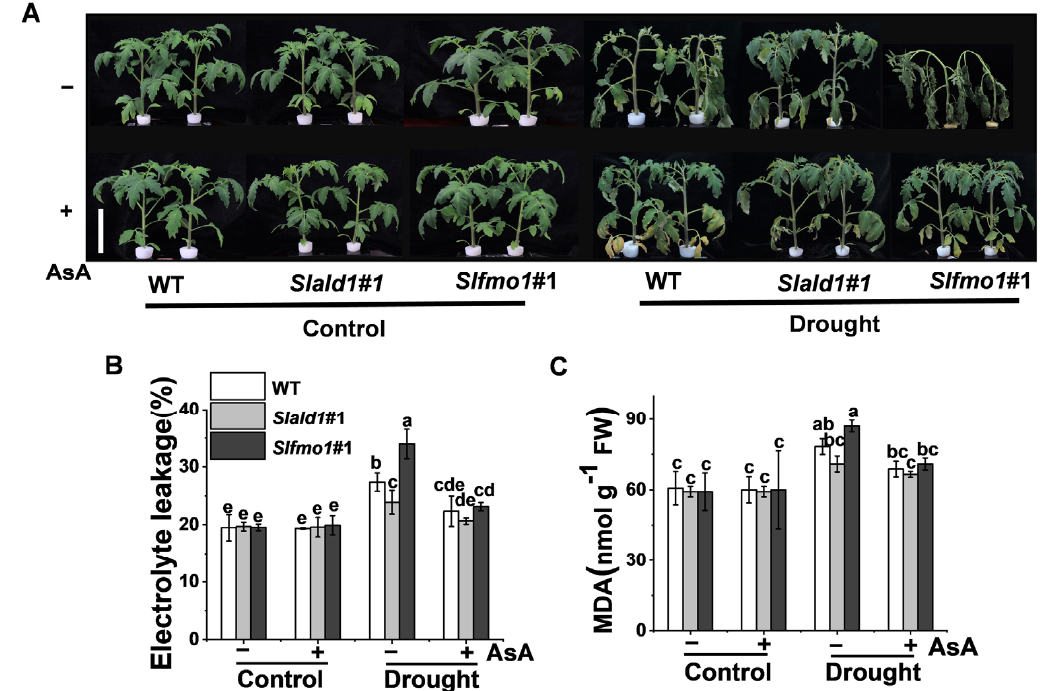
Figure 7. Drought-induced sensitivity in Slfmo1 mutants was alleviated by exogenous AsA. ( A ) Phenotypes of tomato plants under control and drought conditions as influenced by AsA. Before exposure of the plants to control and drought treatment, 10 mM AsA or H 2 O (control) was applied on the foliage of the mutants and WT plants once per day for three consecutive days, and the images of plants were captured at 48 h after the drought treatment. Bar = 10 cm. ( B ) The relative electrolyte leakage in leaves after 48 h of control and drought treatment with or without AsA pretreatment. ( C ) Malondialdehyde (MDA) content in leaves after 48 h of control and drought treatments with or without AsA pretreatment. The data are presented as mean values ± SD, n = 4. Different letters (a, b, c, d, e) above each bar indicate significant differences at p < 0.05 (Tukey’s test) among treatments.